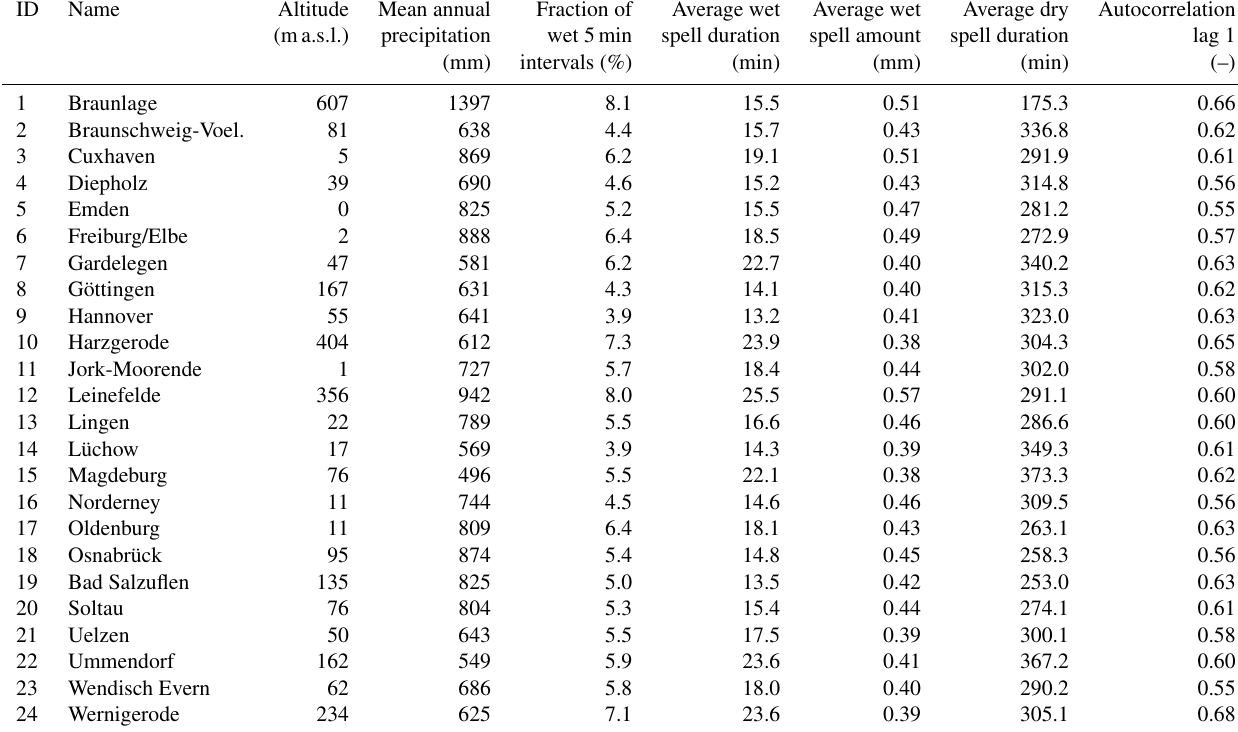
Table 1. Attributes of all 24 rainfall stations, based on a temporal resolution of